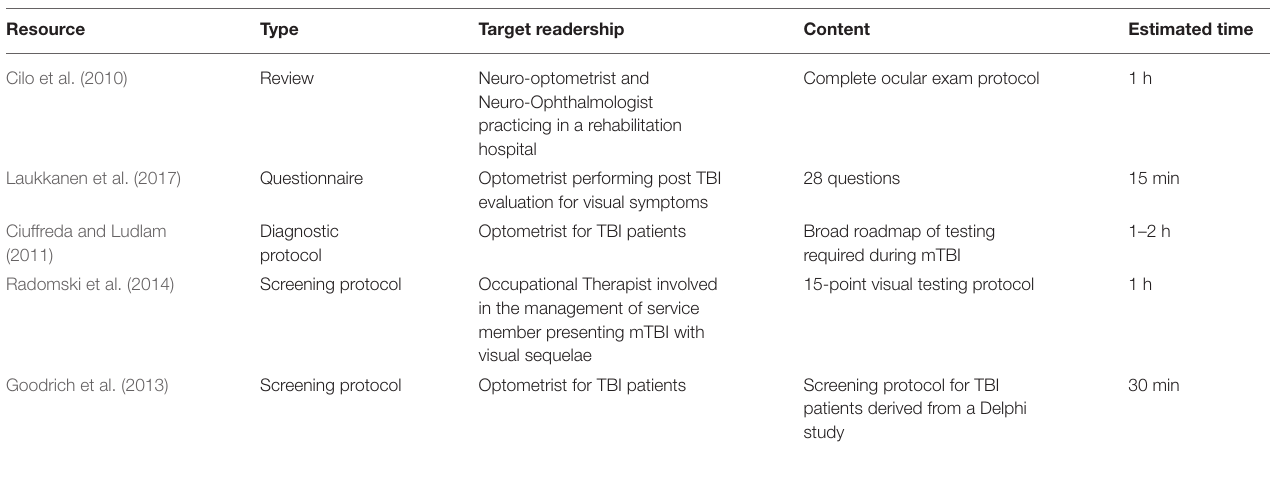
TABLE 1 | Existing post-TBI vision examination